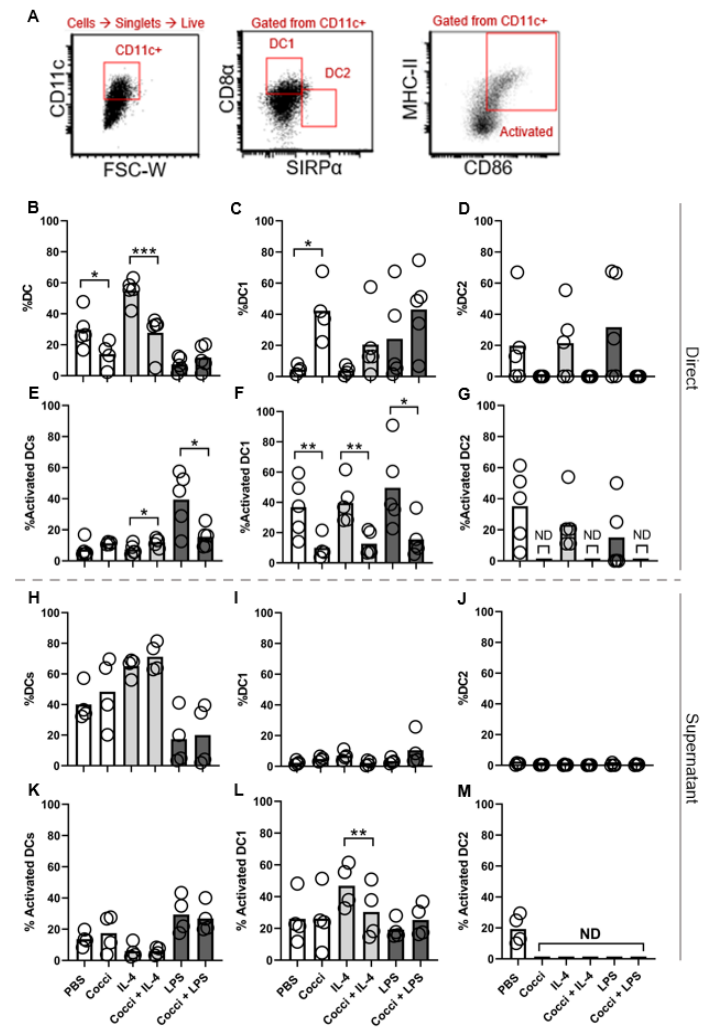
Figure 3. DCs polarize to DC1 in response to Coccidioides but do not upregulate CD86 and MHC-II expression. ( A ) Representative flow plots show gating strategy used for analysis; sample shown is stimulated with Coccidioides . See Supplemental Figure S5 for complete gating strategy. Using a C57BL/6 bone marrow-derived DC culture system to generate DCs, we assessed DC polarization.